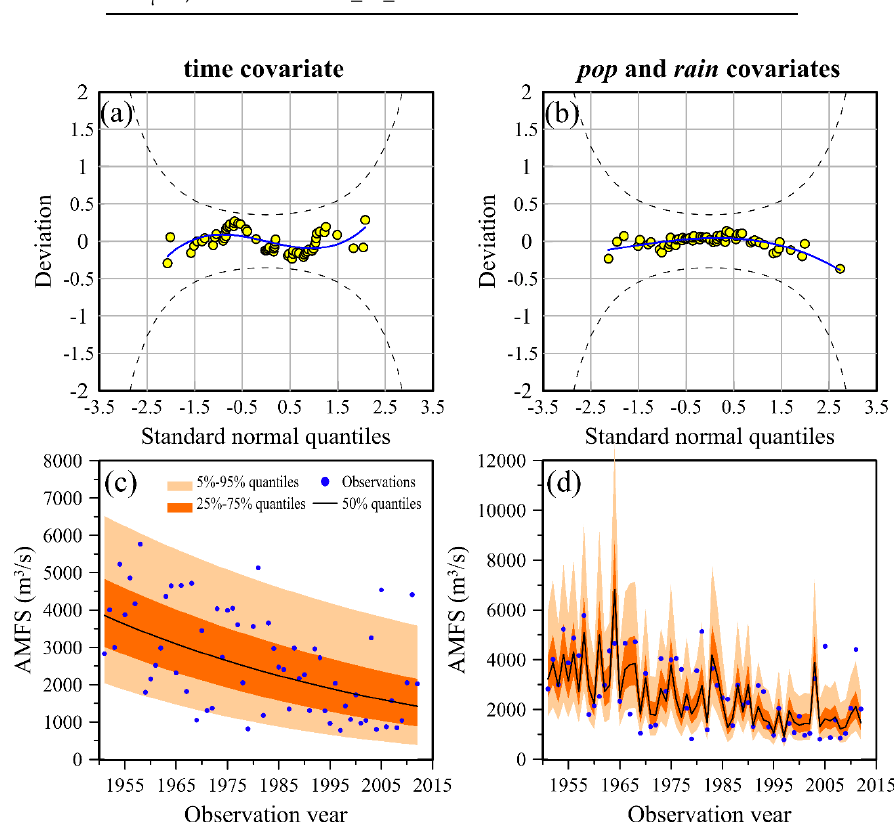
Figure 8. Diagnostic plots for evaluating the goodness-of-fit of the optimal nonstationary models using time covariates and rain and pop covariates for Huaxian station. ( a , b ) are worm plots and ( c , d ) are centile curves plots.